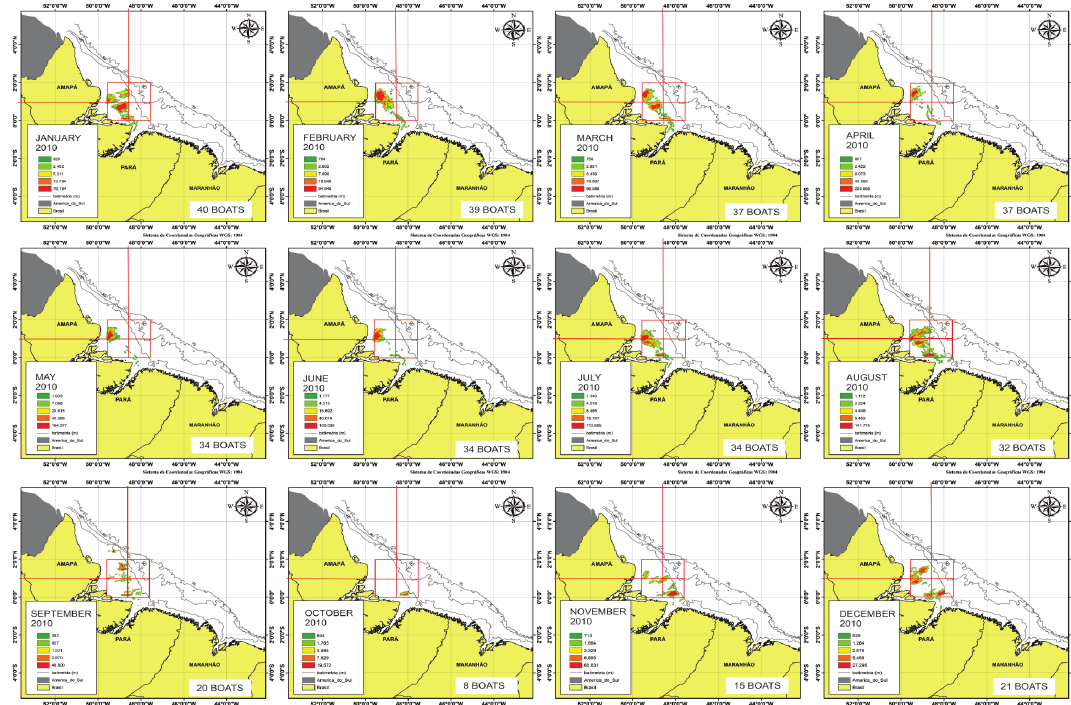
Figure 9. Relative density of fishing activity during the months of 2010 and fishing fleet dynamics divided by